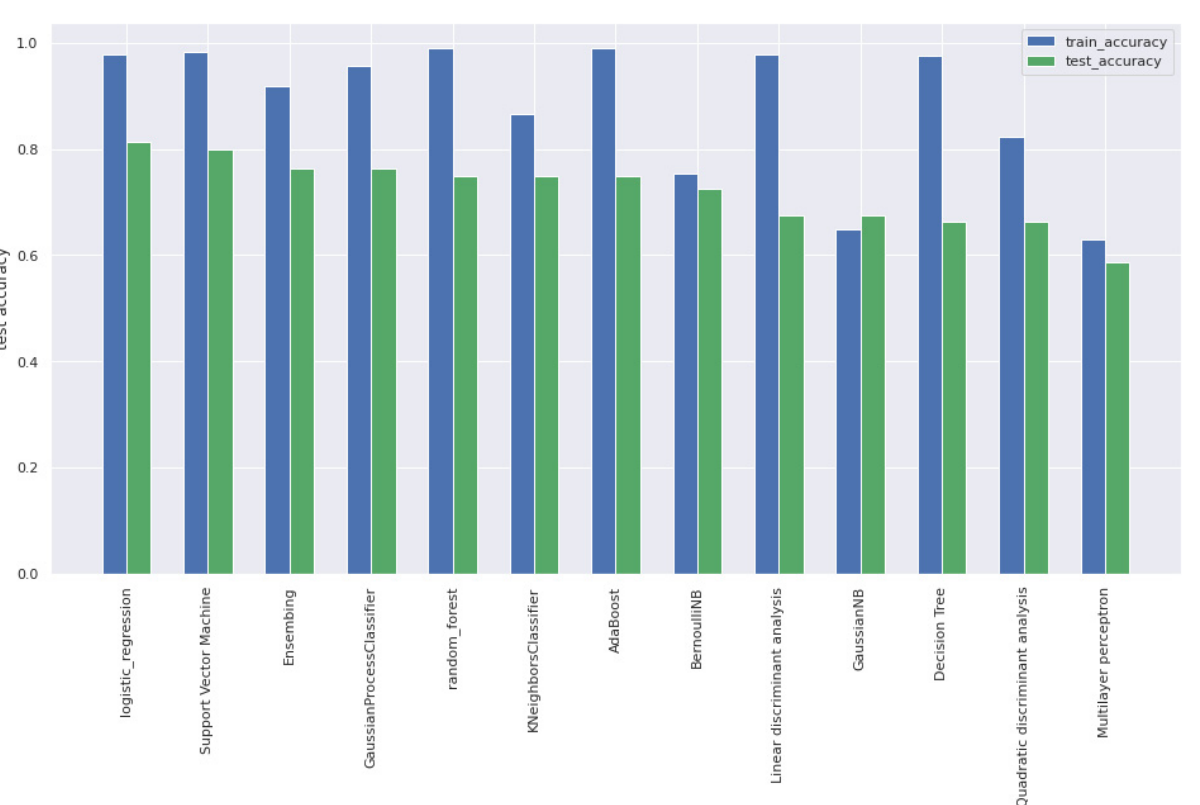
Figure A3. Pair plot of all the score of the analysis 1—Remobi saccade dataset.